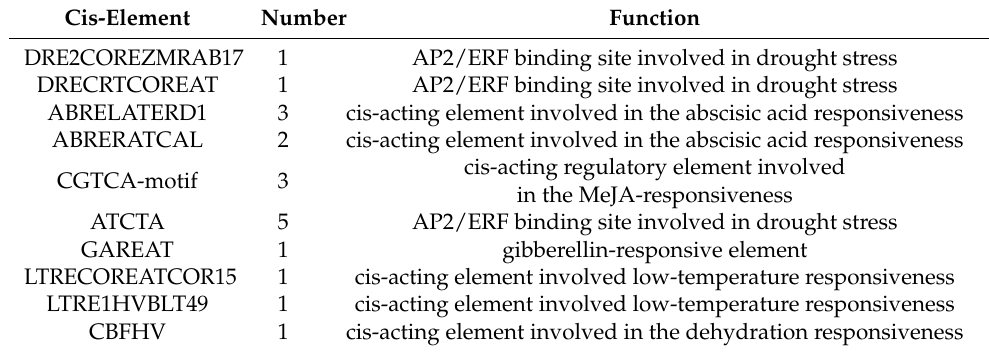
Table 1. Analysis of cis-elements in the OsGA2ox8 promoter